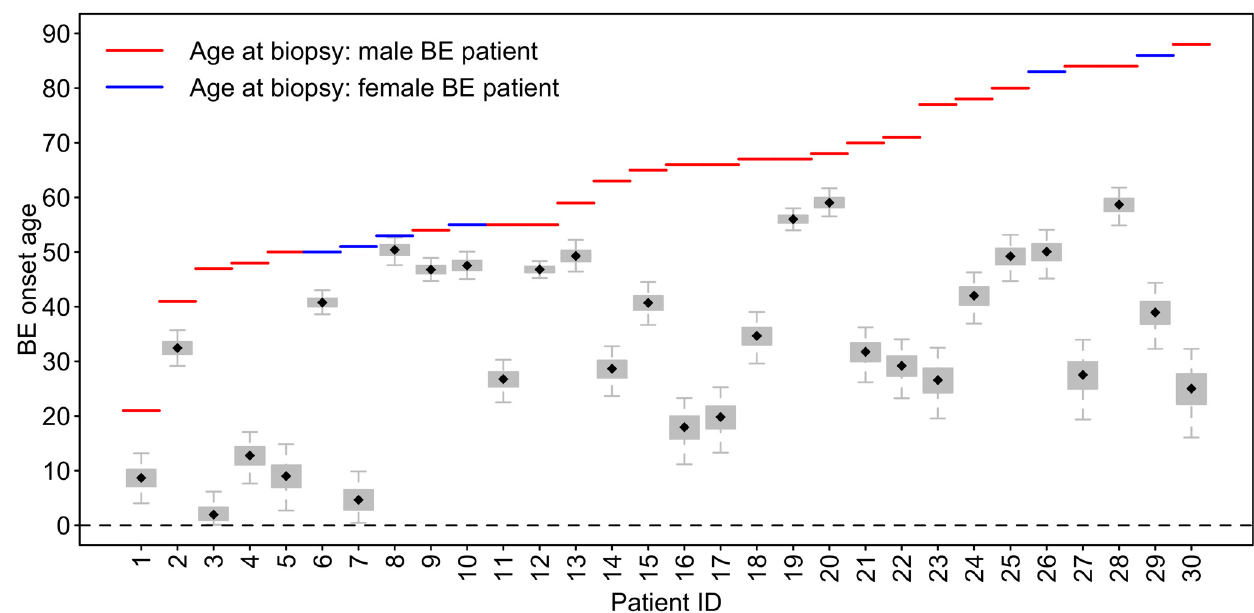
Fig 6. Predicted BE onset times for 30 BE patients in D2. Boxplots depict the MCMC simulated posterior BE onset time distributions for all 30 patients, s i , i = 1, ... , 30, in data set D2. The MCMC estimates suggest large inter-individual heterogeneity in BE onset times (median onset age = 33.6, range = [2.0, 59.0]), which translates into widely varying EAC risk predictions between patients.